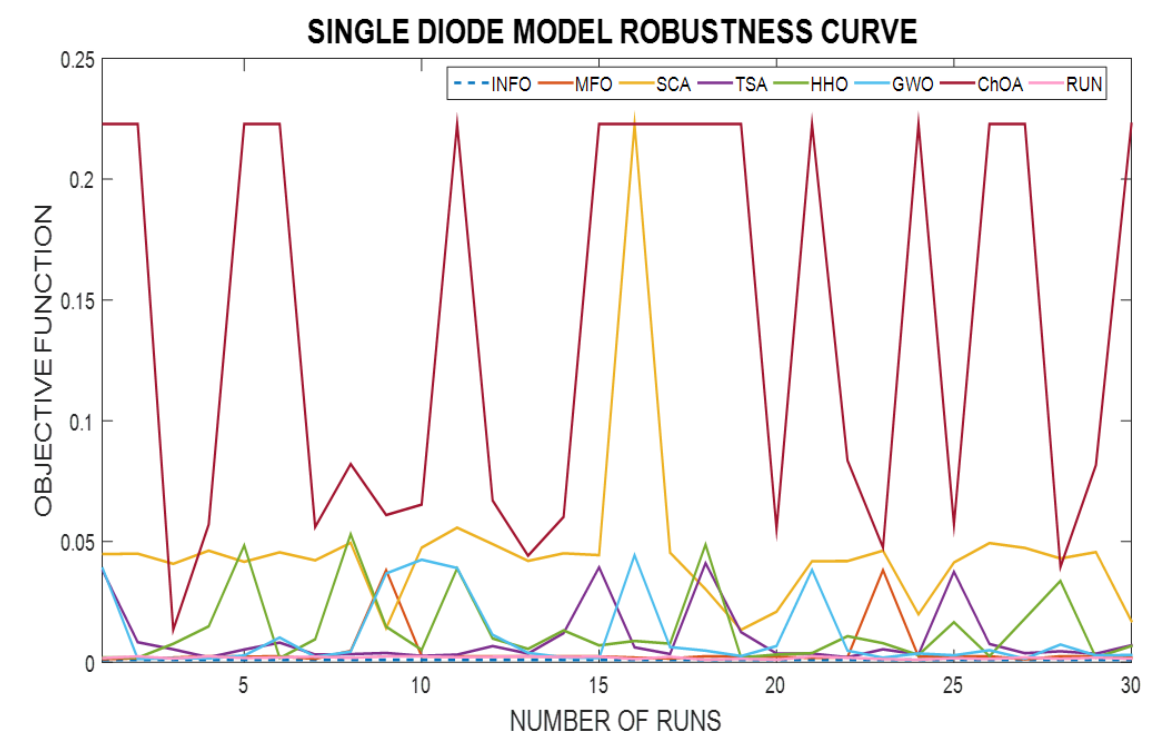
Figure 13. Robustness curve of the SDMSC.